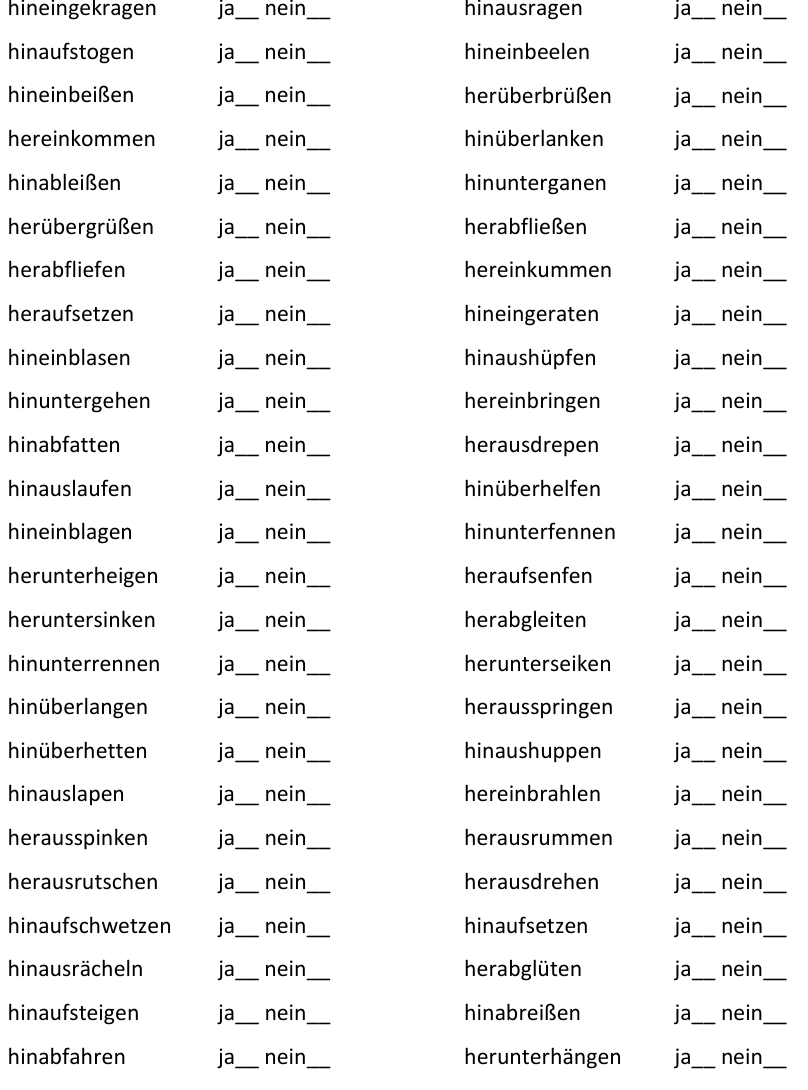
Figure A1. Lexical decision task.